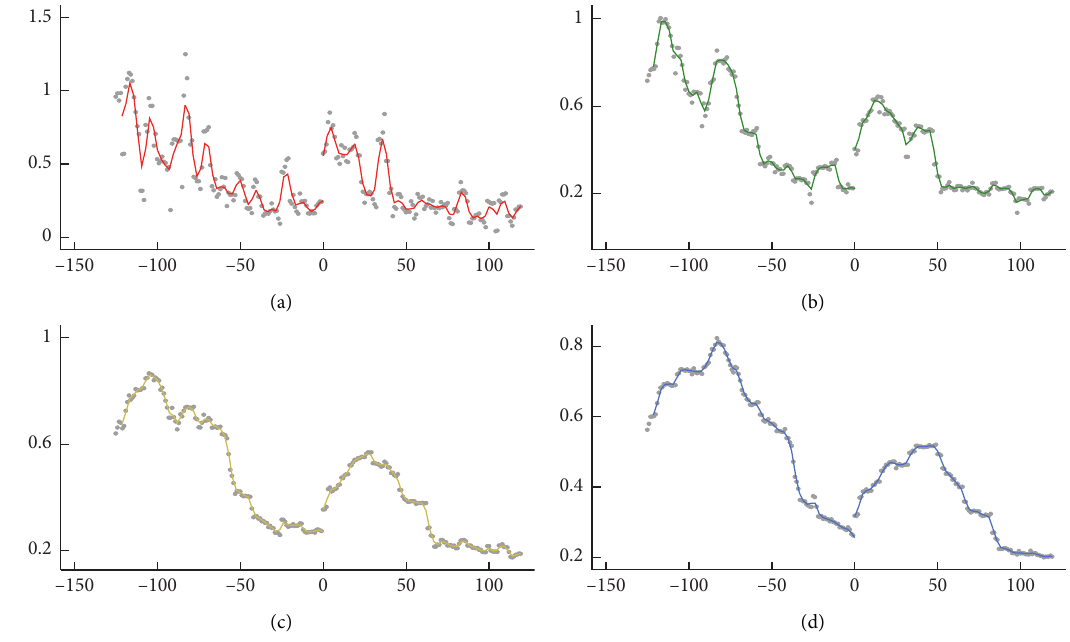
Figure 3: The RDD results of the industry. (a) hv5, (b) hv15, (c) hv30, and (d) hv50.